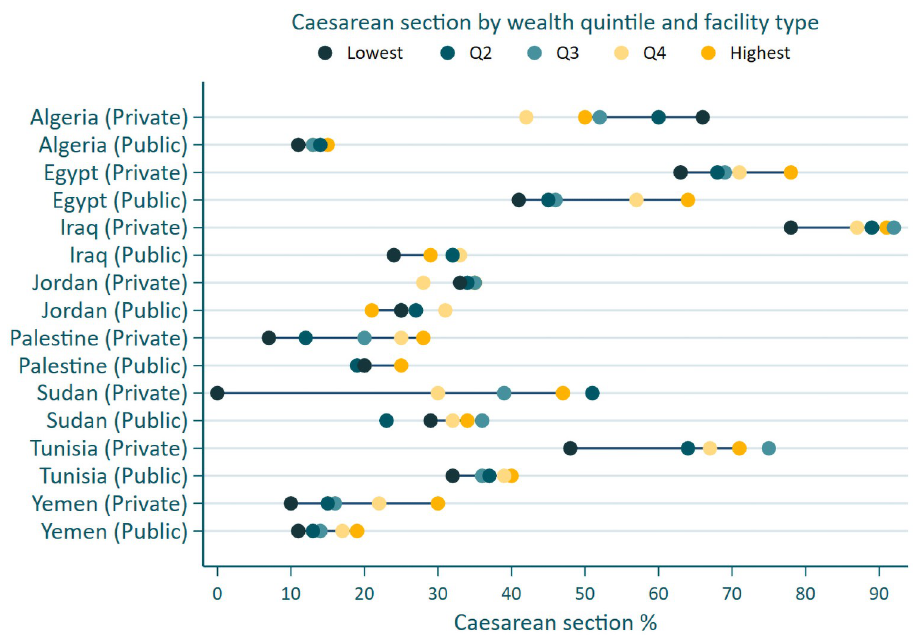
Fig 5. Caesarean section use in public and private sector facilities, by wealth quintile and country, for the most recent survey. Last DHS/MICS survey was used. Qatar did not collect wealth quintile.